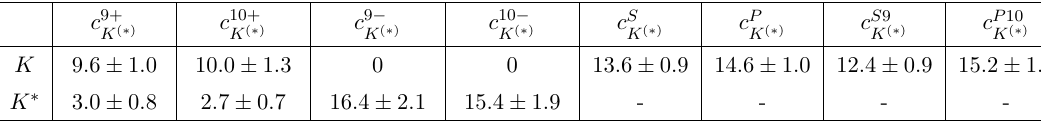
Table 8 . Hadronic coe(cid:14)cients for the B ! K ( (cid:3) ) (cid:28)(cid:22)